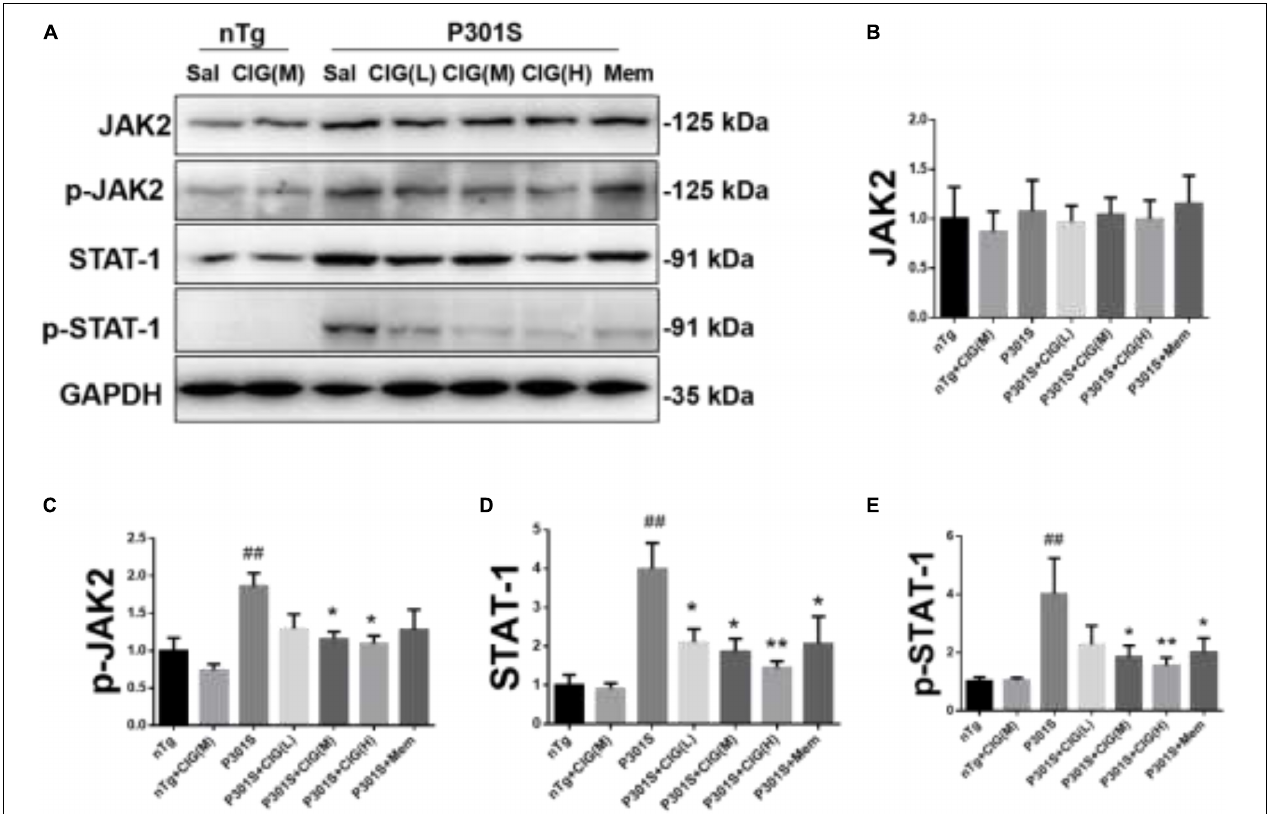
FIGURE 5 | Cornel iridoid glycoside (CIG) treatment inhibited the JAK2/STAT1 signaling pathway in the brain of P301S mice. (A) Representative images of Western blotting for JAK2, phosphorylated JAK2 (Tyr1007/1008, p-JAK2), and STAT1, phosphorylated STAT1 (Tyr701, p-STAT1) in the brain of mice. Quantification of Western blotting for JAK2 (B) , p-JAK2 (C) , STAT1 (D) , and p-STAT1 (E) in the brain. Data are expressed as mean ± SEM; n = 4 each group. ## P < 0.01, P301S transgenic mice vs nTg control mice; * P < 0.05, ** P < 0.01, drug-treated P301S mice vs saline-treated P301S mice. JAK2, Janus kinase-2; STAT1, signal transducer and activator of transcription